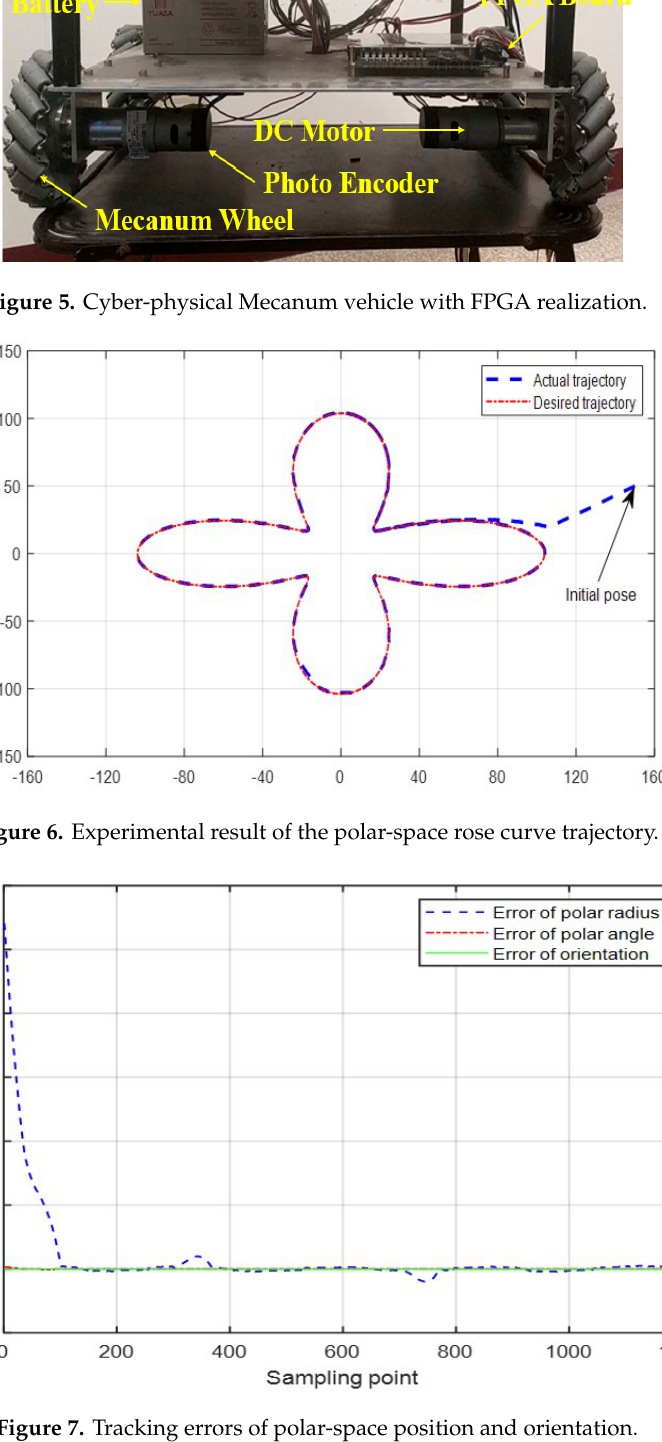
Figure 7. Tracking errors of polar-space position and Figure 2. Scheme of the experimental procedure.